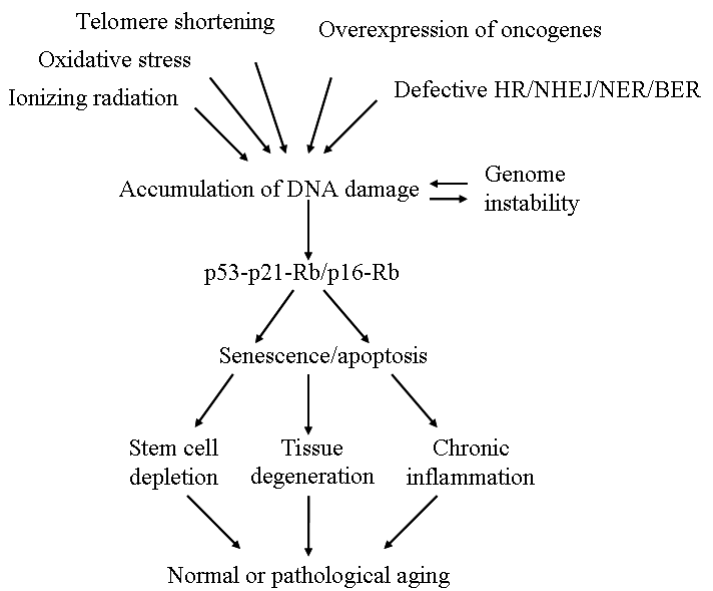
Figure 1. A model for the role of unresolved DNA lesions in aging.